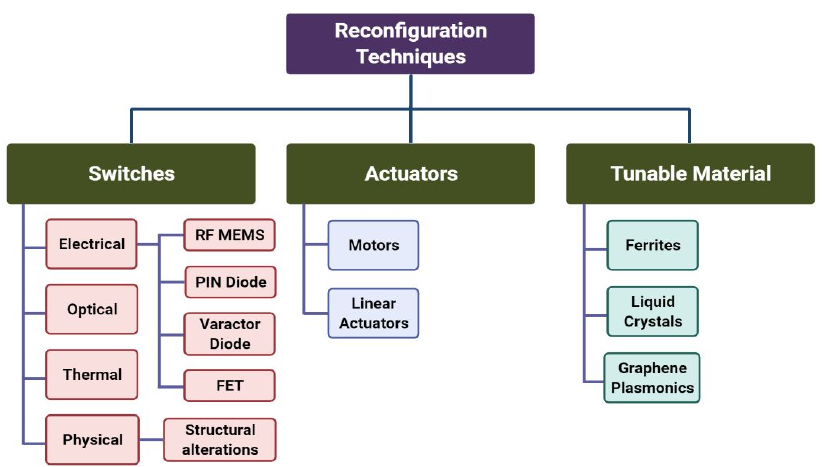
Figure 1. Different techniques of achieving antenna reconfigurability.